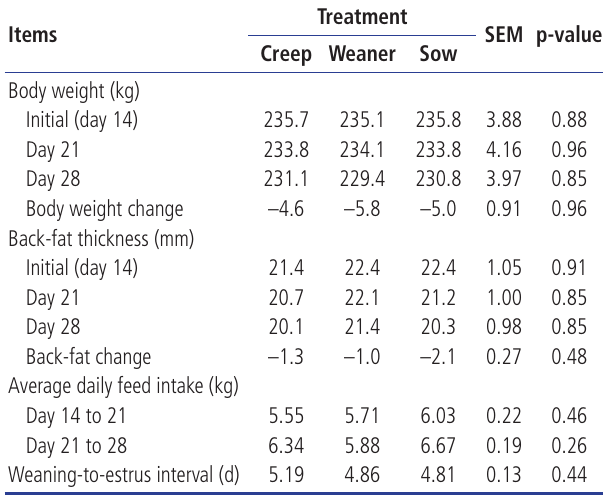
Table 2. Effect of different creep feed types on sow performance